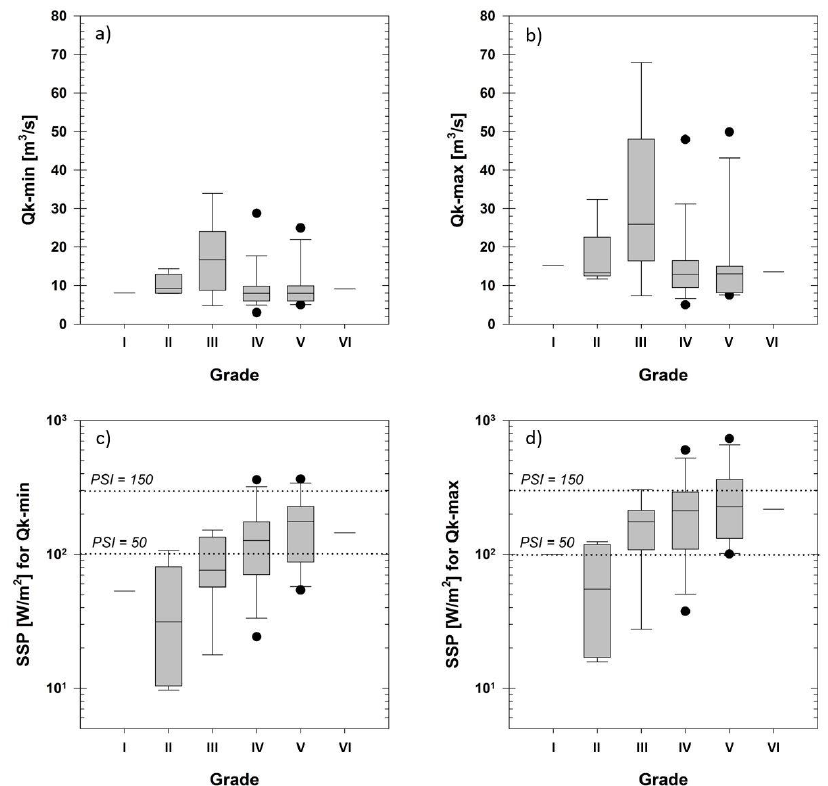
Figure 7. Minimum ( a ) and maximum ( b ) kayak flows and the respective SSP of kayak runs ( c, d ) as function of difficulty grade. SSP was calculated using the minimum (Qk-min) and maximum (Qk-max) kayak flows as reference discharge. The power surface index (PSI) thresholds of 50 and 150 are suggested for runs of regional significance and world championship standard, respectively. The ratio Qk-min/MQ ranged between 0.3 and 2.2. Figure 8, (left) indicates that this ratio